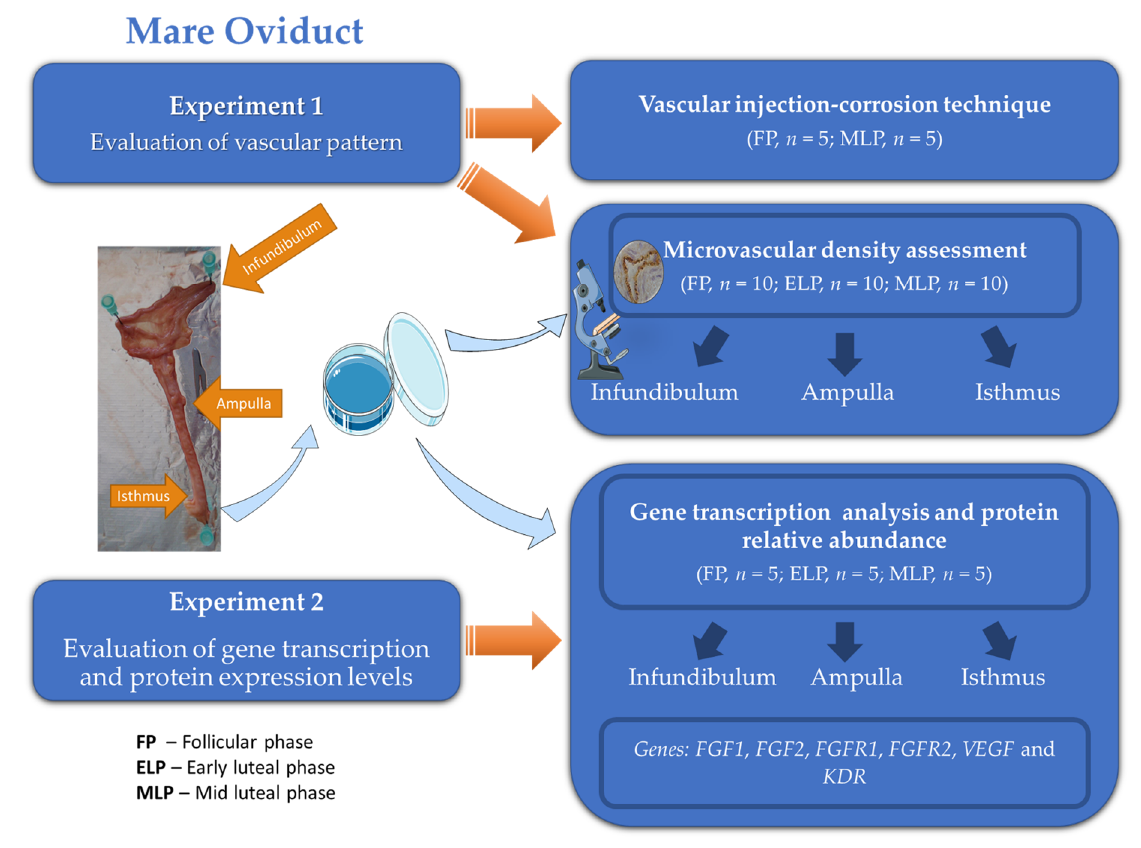
Figure 1. Graphical representation of the experimental